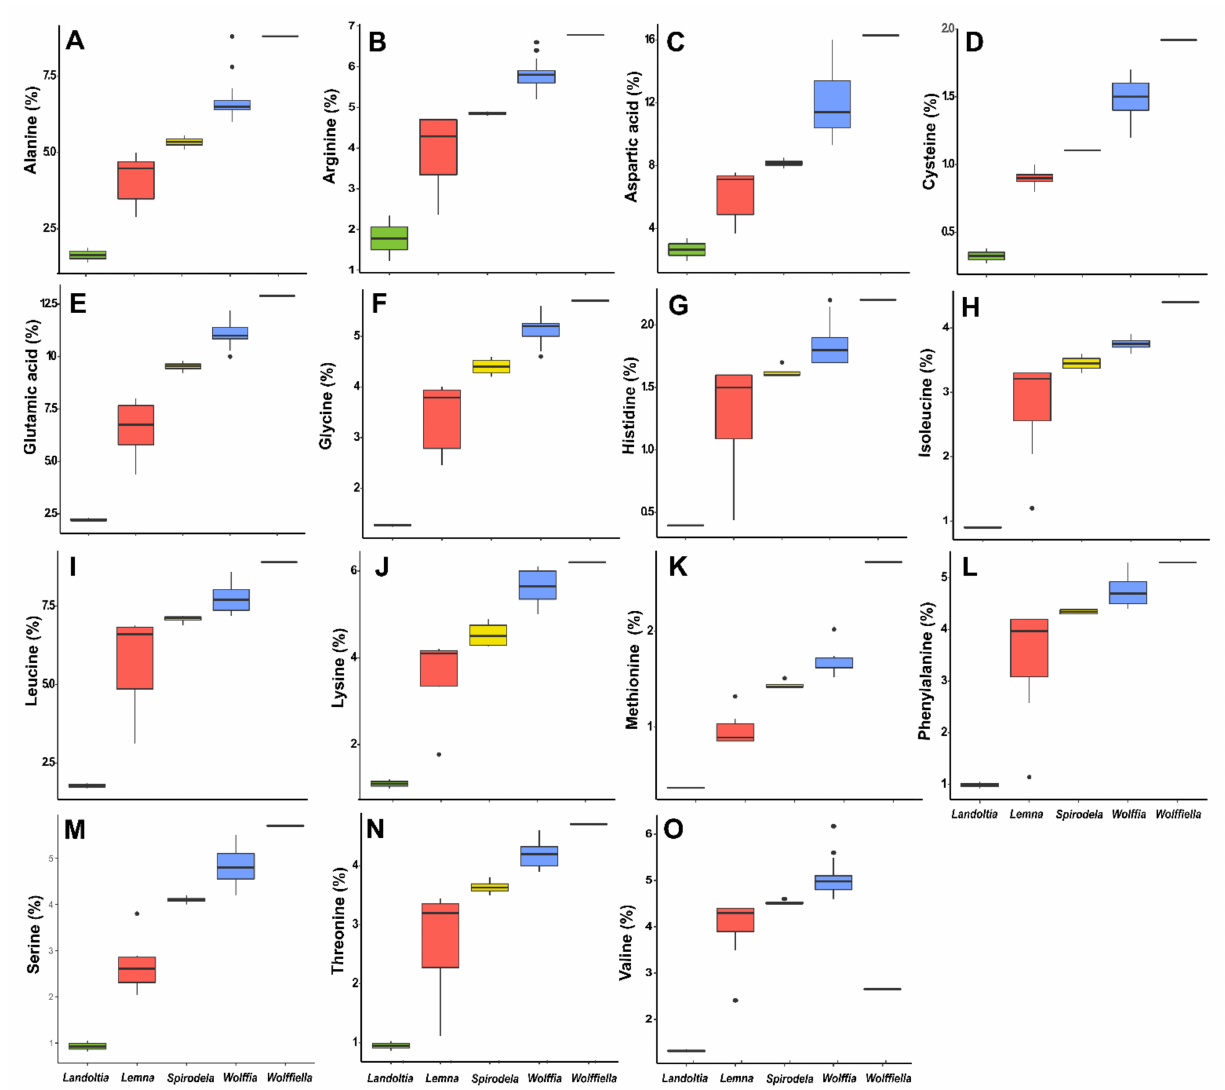
Figure 4. Amino acids levels in duckweeds by the percentage of protein. The data is shown in boxplots of the conversion of the percentage of protein of each amino acid recovered in the systematic review. ( A ) Alanine. ( B ) Arginine. ( C ) Aspartic acid. ( D ) Cysteine. ( E ) Glutamic acid. ( F ) Glycine. ( G ) Histidine. ( H ) Isoleucine. ( I ) Leucine. ( J ) Lysine. ( K ) Methionine. ( L ) Phenylalanine. ( M ) Serine. ( N ) Threonine. ( O )